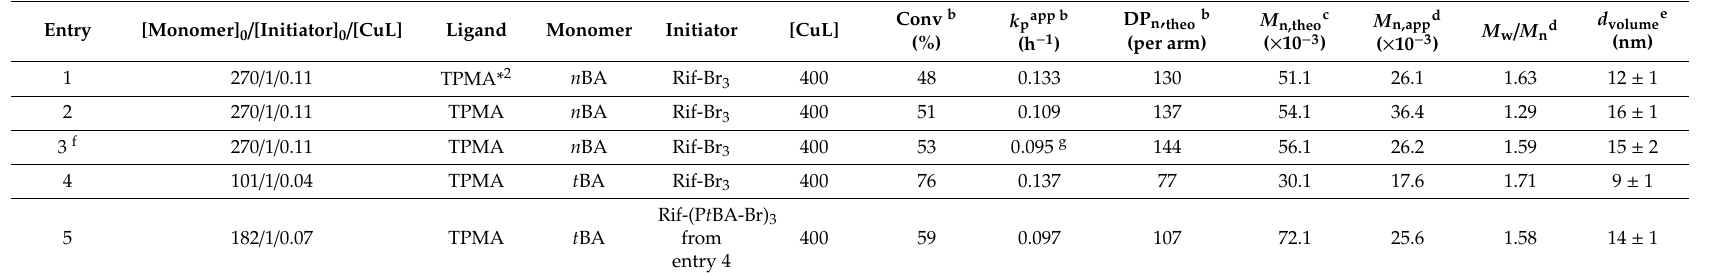
Table 1. Polymerization of acrylates from rifampicin-based ATRP macroinitiator via se ATRP a